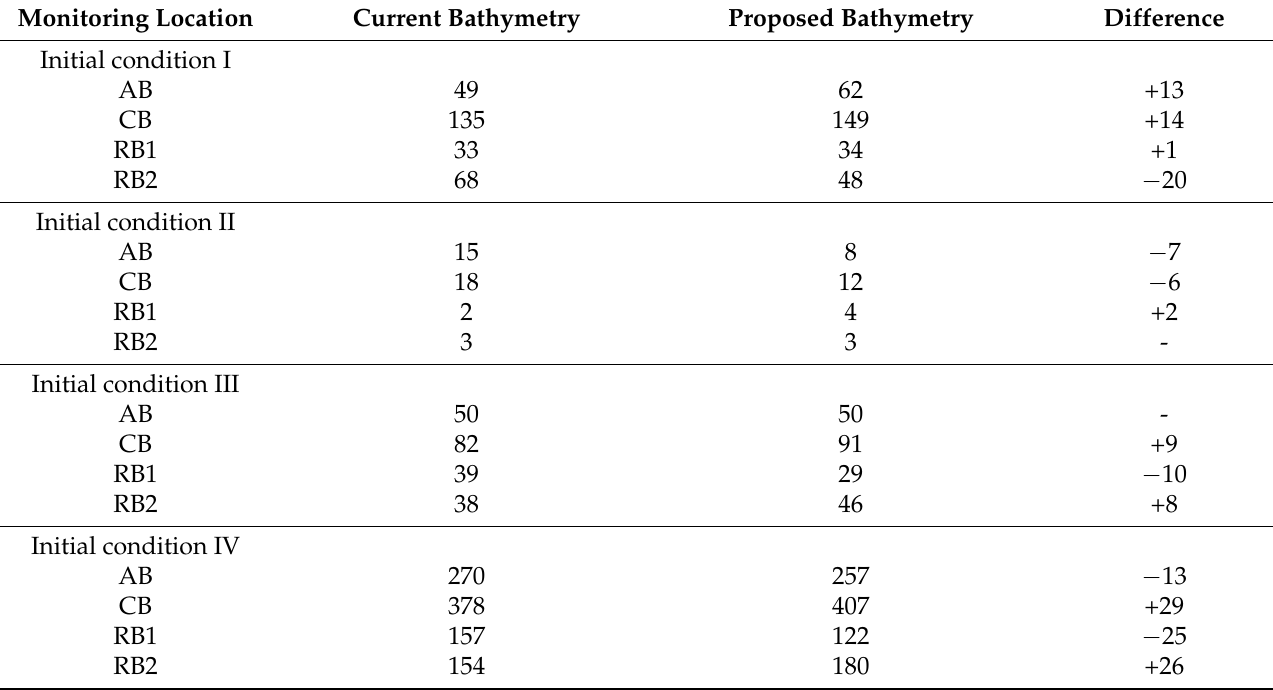
Table 4. Larvae counting location data for 2019